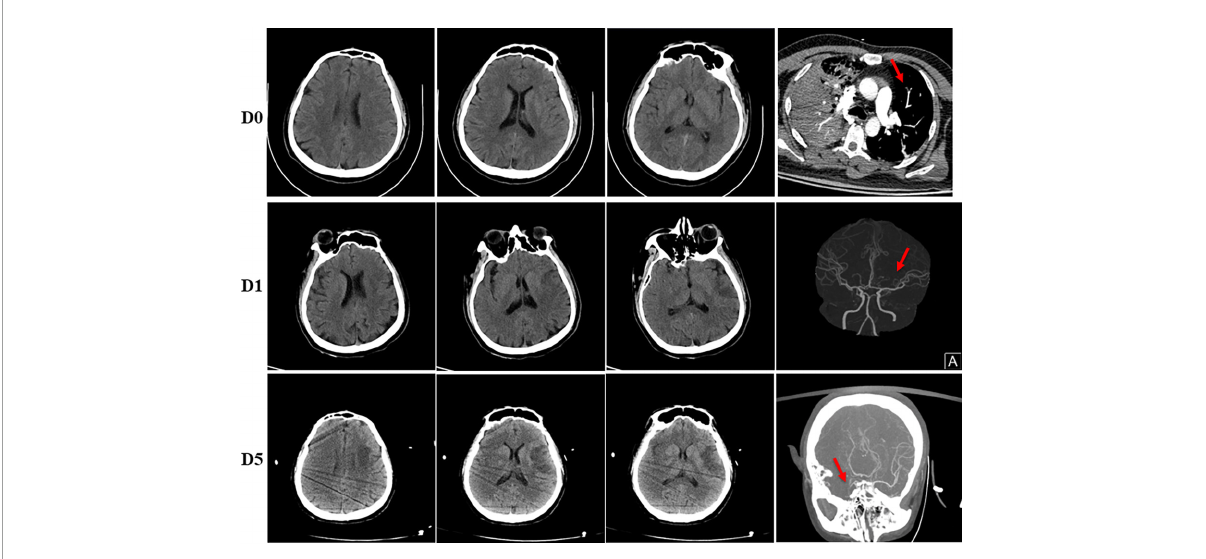
FIGURE2 Head imaging of the patient. (D0) Normal head CT before admitted. His CTPA showed embolism of left pulmonary artery branches (red arrow). (D1) Ischemic infarction of left frontal and temporal lobes was shown in his head CT on day 1 after admitted, CTA examination showed stenosis of the left MCA (red arrow). (D5) CT scan of head on day 5 showed no obvious difference compared to day 1, however, CTA examination showed occlusion of right MCA (red arrow).